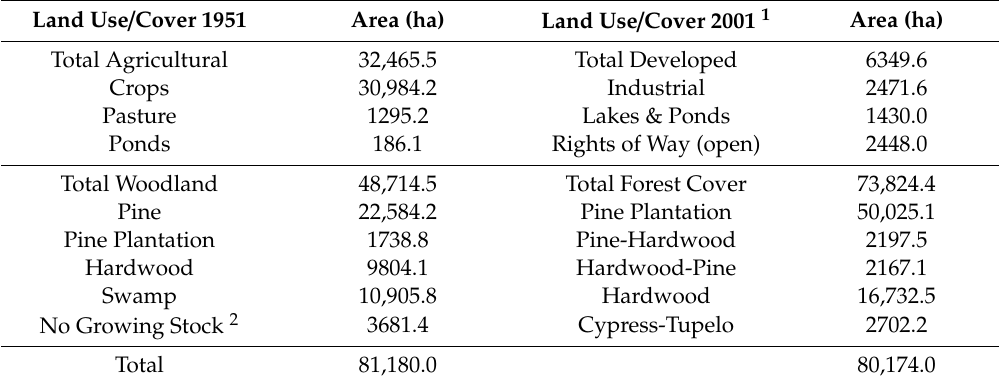
Table 1. Land use and land cover conditions in 1951 and 2001 based on the inventories during those periods. Woodland and forest cover groups are described in the